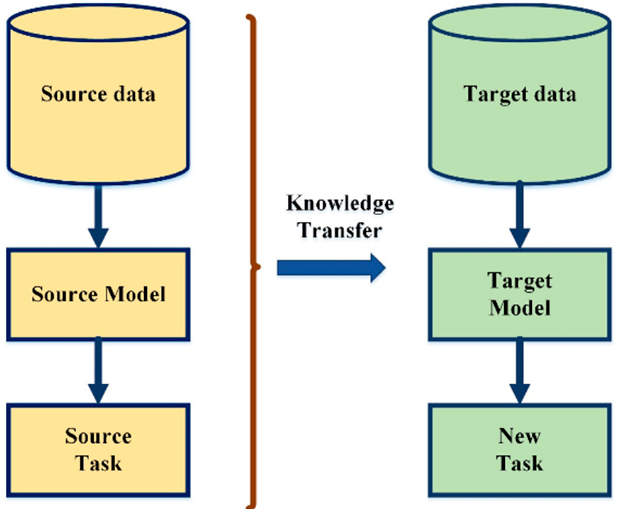
Figure 1. Basic layout of the standard transfer learning process.